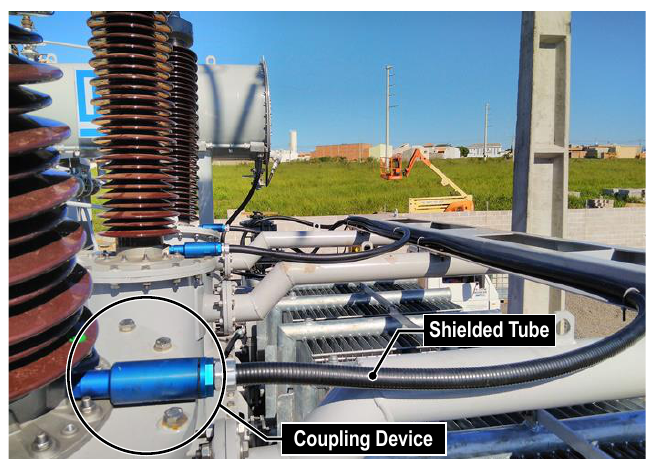
Figure 20. Coupling devices connected in high voltage (HV) bushings. Energies 2020 , 13 , x FOR PEER REVIEW